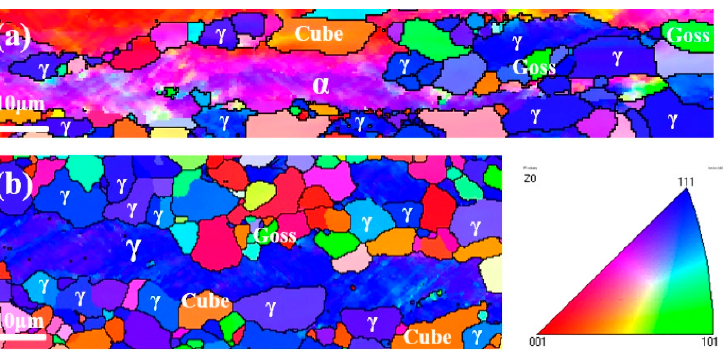
Figure 8. Recrystallized texture at the grain boundaries at 700 °C: ( a ) deformed α grains and ( b ) deformed γ grains.